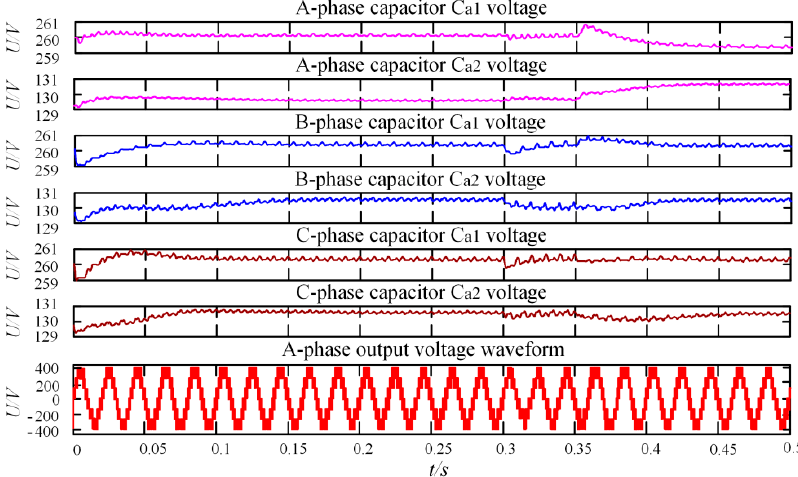
Figure 14. Each capacitor-voltage and the A-phase output voltage Figure 14 . Each capacitor-voltage and the A-phase output voltage waveform. Figure 14 . Each capacitor-voltage and the A-phase output voltage waveform. Figure 14 . Each capacitor-voltage and the A-phase output voltage waveform.